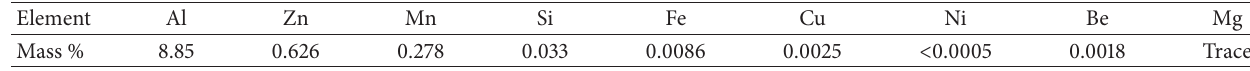
Table 1: Chemical composition of AZ81 magnesium